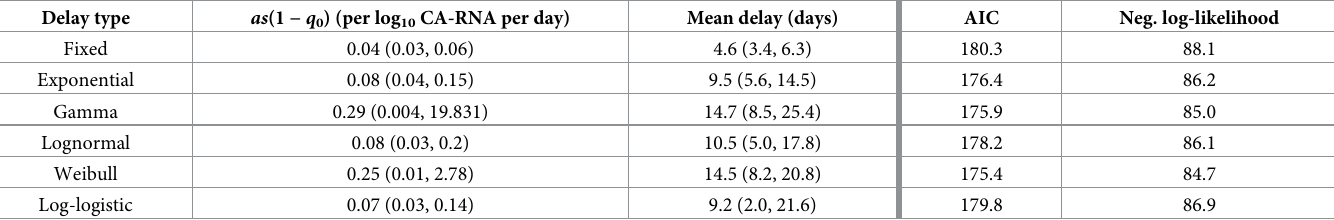
Table 2. Key parameter estimates for model (1), making no distinction between participants based on pre-ATI ART regimen, with the 95% confidence interval indi- cated in parentheses. All parameter provided in S1 Table. Delay type